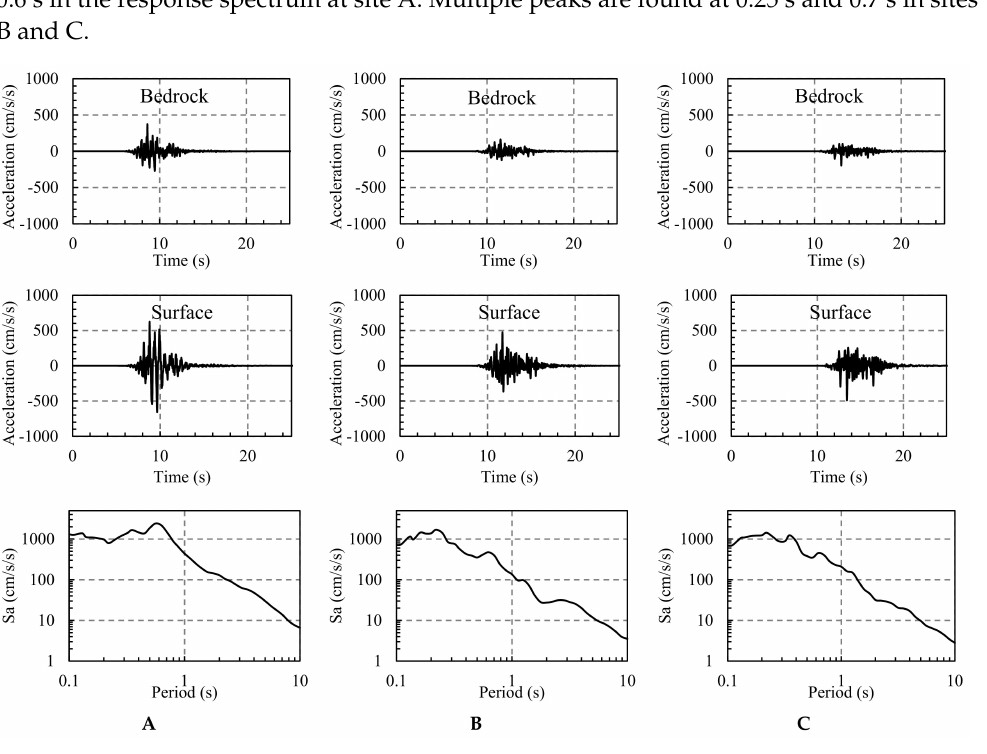
Figure 13. Acceleration time histories at seismic bedrock and ground surface, and response spectra estimated by SGFM and equivalent linear seismic response analysis of DYNEQ at site ( A – C ) shown in Figure